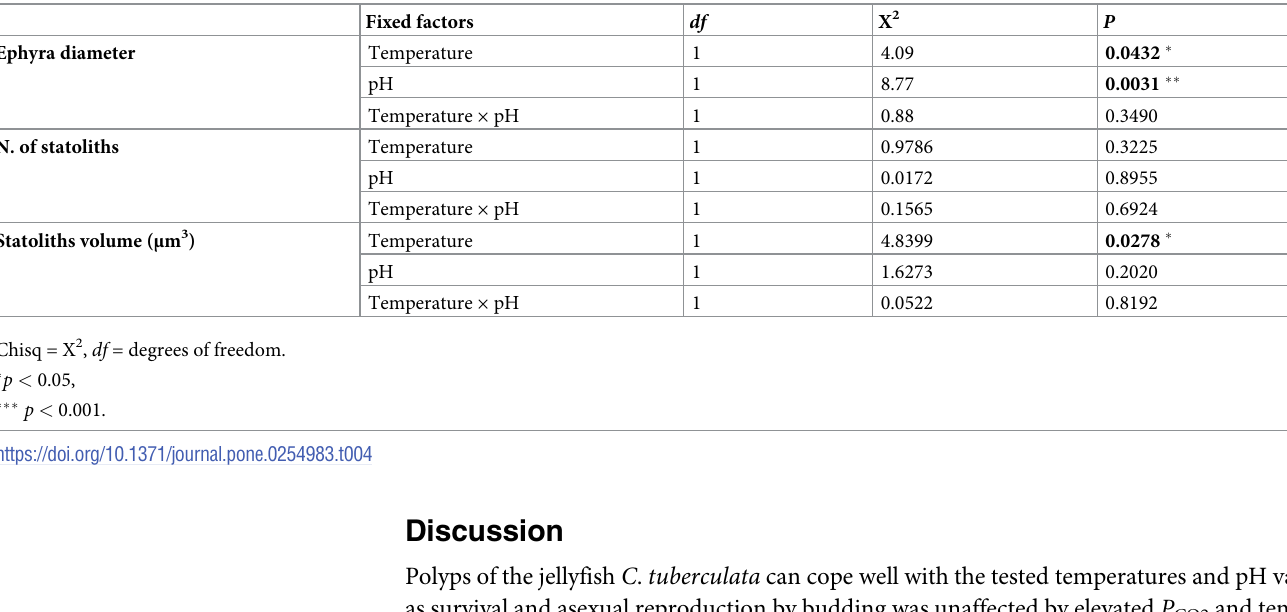
Table 4. Summary of results of the linear mixed-models analysis of the ephyrae diameter ( n = 24), number of statoliths ( n = 13) and statolith volume ( n = 13).